Question: Describe this figure in one sentence.
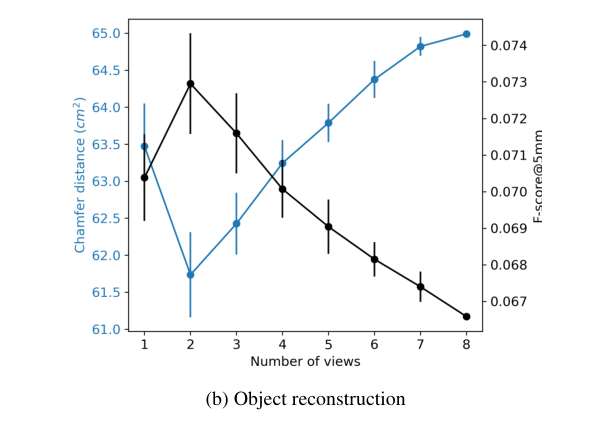
Answer: Average F-score and standard deviation across 6 runs for (a) hand and (b) object reconstruction when varying the number of input views